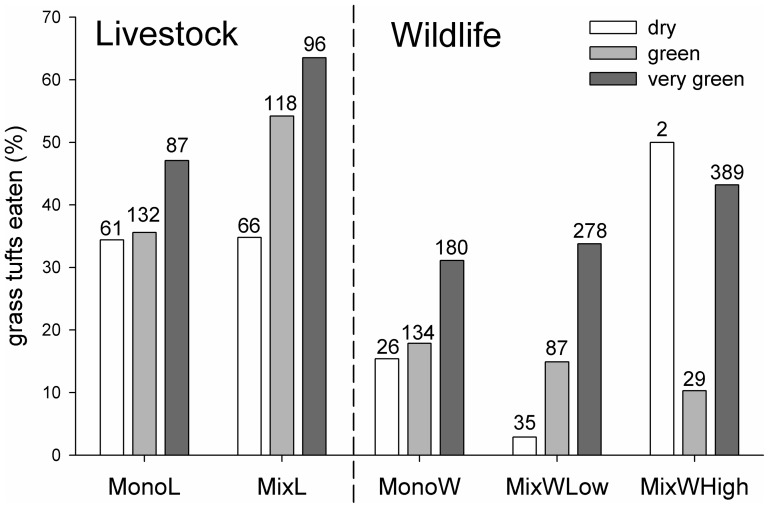
The average percentage of grazed grass tufts according to their absolute greenness values across the five study site types defined in Table 1.Numbers above bars indicate sample size.